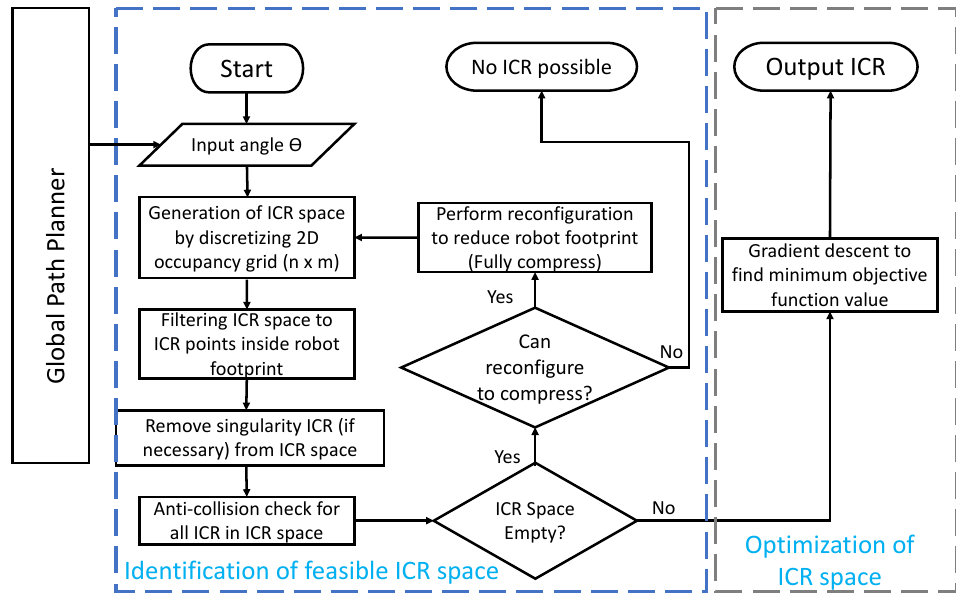
Figure 4. Flowchart for proposed ICR